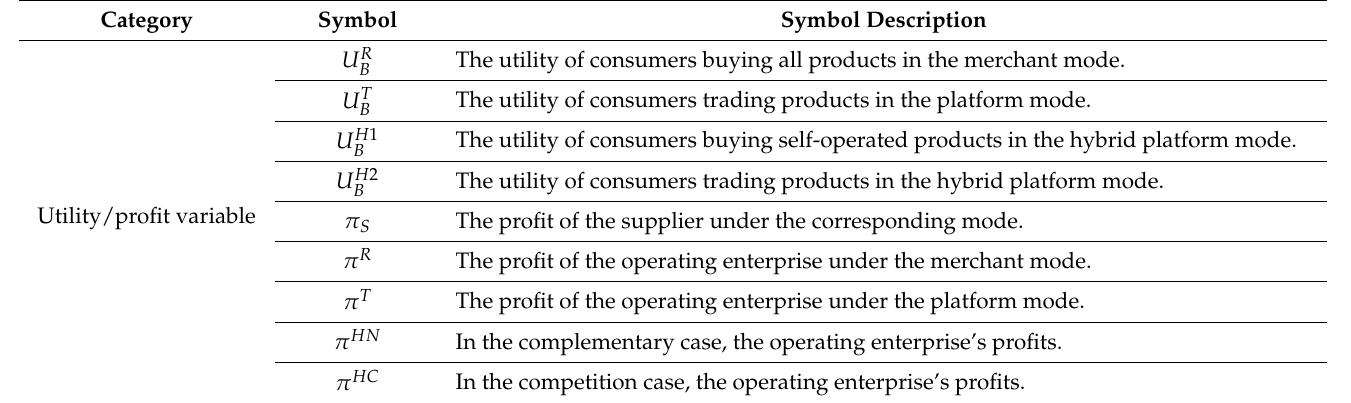
Table 1 collates the definitions and descriptions of symbols used in this article. Table 1. Definitions and descriptions of